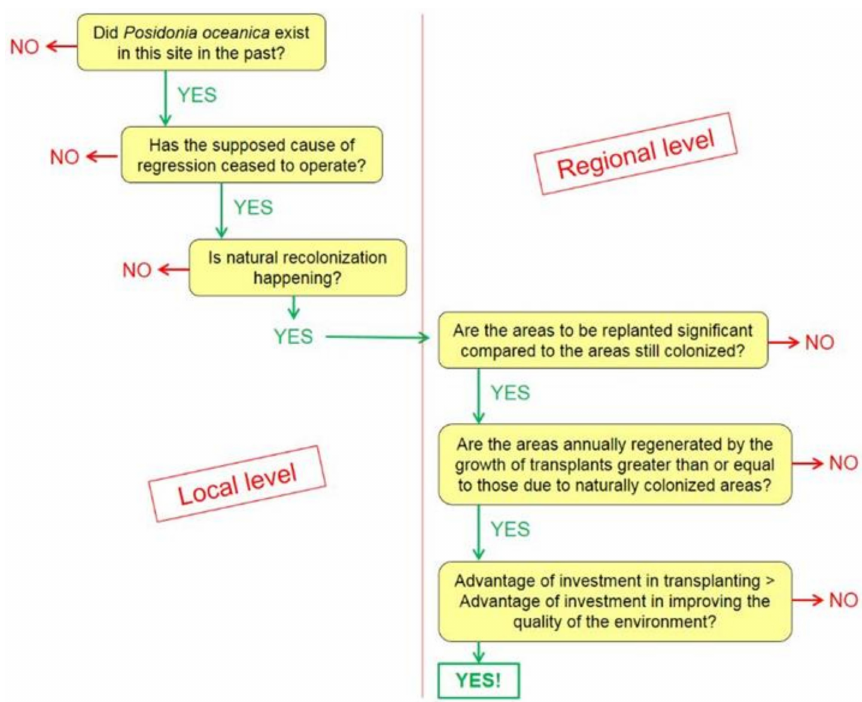
Figure 14. Decision-making strategy for transplanting Posidonia oceanica and other seagrasses. The question–answer sequence first looks at the local level (the site of the anticipated transplanting) and then the regional level (a homogenous area, such as a bay). “No” answer should lead to the project being abandoned. From Boudouresque [183], adapted and